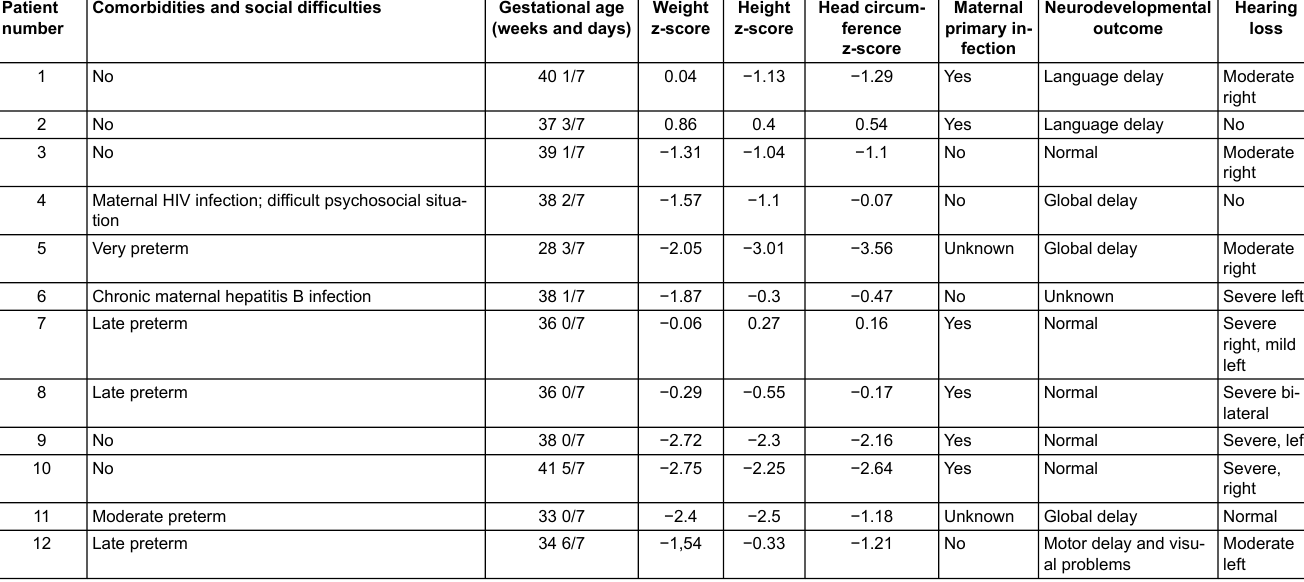
Table 2: Baseline characteristics, audiological and neurodevelopmental outcomes of children with